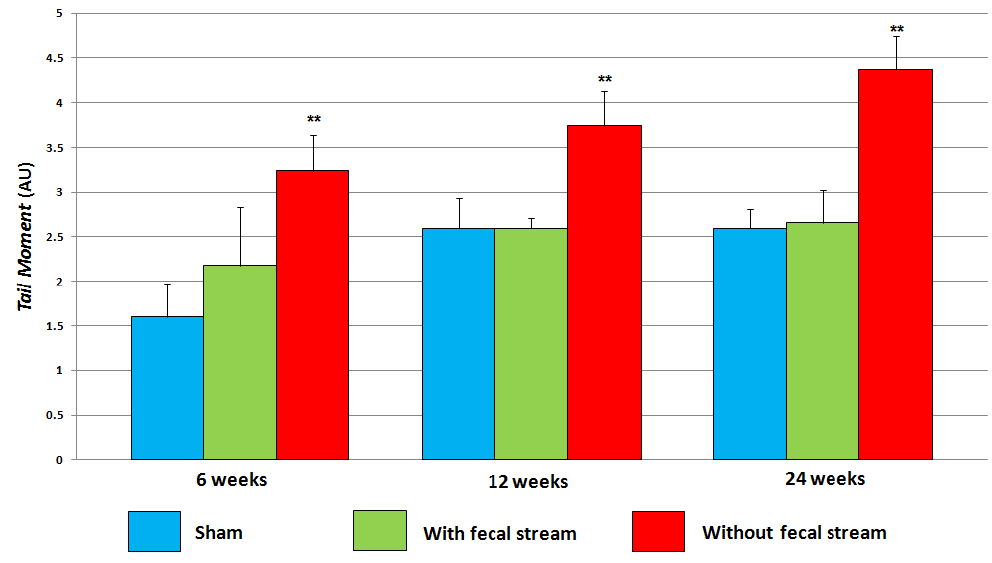
FIGURE 4 – Mean TM values in control and experimental subgroups (colon segments with and without fecal stream), for the different durations of fecal stream diversion. ** = significant (without fecal stream × control and with fecal stream). Student t